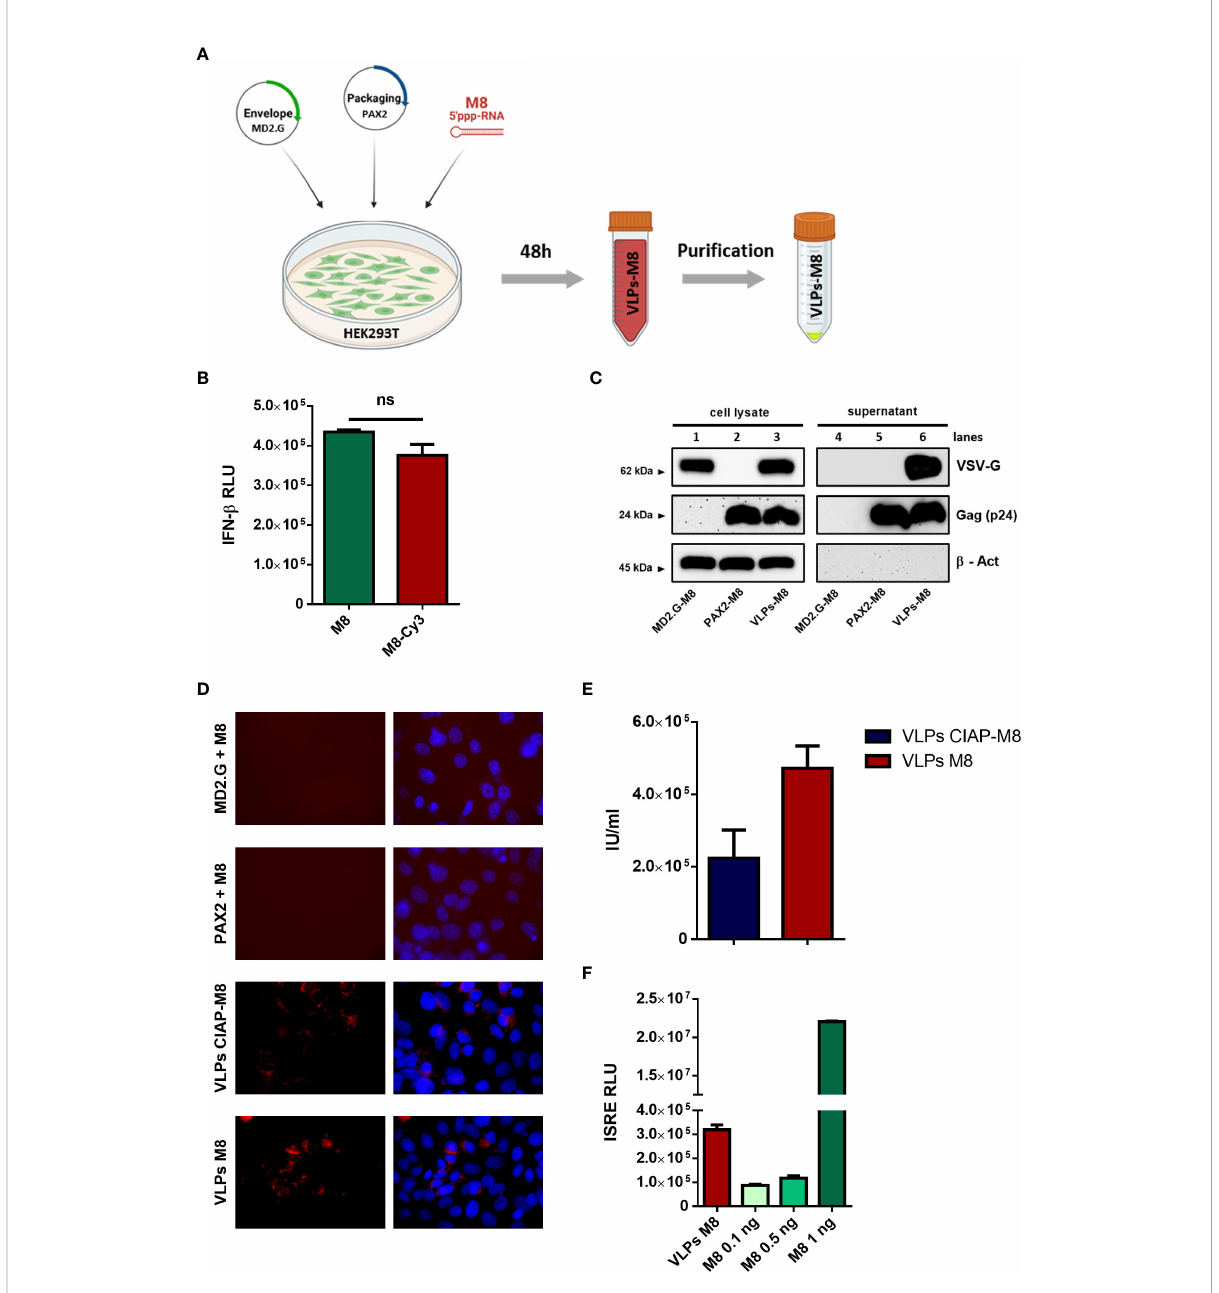
FIGURE 1 Generation and characterization of VLPs-M8 (A) Schematic representation of VLPs generation. HEK293T cells were seeded in a T-75 fl ask and after 24h were transfected with plasmids encoding for envelope and packaging, together with M8 or the negative control CIAP-M8. 48h after transfection supernatants were collected then puri fi ed and concentrated by ultracentrifugation. The fi gure was created with BioRender.com. (B) Comparison between M8 and M8-Cy3 induction of IFN response. M8 and M8-Cy3 were transfected in HEK293T reporter cell line expressing fi re fl y luciferase under IFN- b promoter (IFN- b luc). Luciferase activity was measured 24h after transfection and indicates the induction of IFN- b promoter. (ns: not signi fi cant) (C) Immunoblot analysis representative of VSV-G and Gag-p24 protein expression in HEK293T whole cell extract and supernatant containing VLPs. Protein expression was normalized on b -Actin. (D) Representative images of M8-Cy3 and CIAP-M8-Cy3 localization. Analysis of VERO E6 cells seeded in a 24-well plate and treated for 48h with incomplete or complete VLPs, images were obtained using a Olympus fl uorescence microscope (100x magni fi cation) and analyzed by ImageJ. (E) Calculation of VLPs titer. VLPs-CIAP-M8 and VLPs-M8, both expressing Cyanine-3, were added to VERO E6 cells and the percentage of Cy-3 positive cells was measured after 48h by fl ow cytometry. VLPs titer was then calculated as described in Materials and Methods. (F) IFN signaling activity. Supernatants of A549 cells treated with VLPs-M8 (20µg) or M8 at the indicated concentrations, were collected after 48h of treatment and tested on HEK293T reporter cell line expressing fi re fl y luciferase under ISRE promoter (ISRE-luc). Luciferase activity was measured 24h after treatment and indicates the induction of ISRE